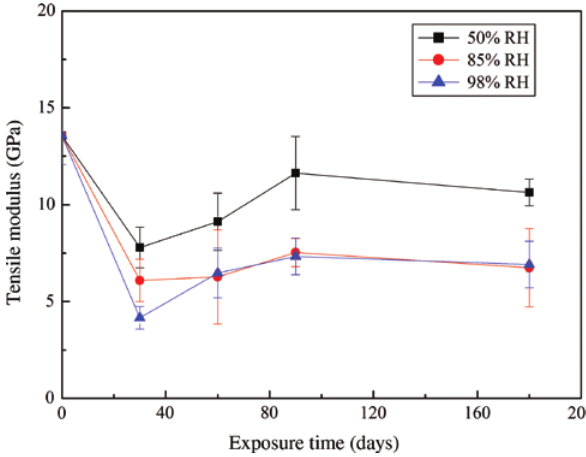
Figure 5 Variation of the tensile modulus as a function of exposure time of ramie fiber fabric reinforced phenolic resin under three humidity conditions at room temperature.